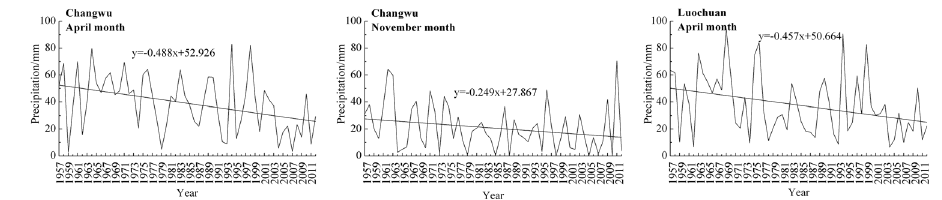
Fig 2. Variations of monthly precipitation at the stations with significant trends during the study period.